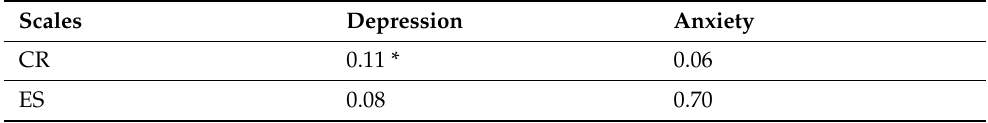
Table 7. Correlations between scales of the Malay version of the ERQ-CA and the DASS-21. Scales Depression Anxiety CR 0.11 * 0.06 ES 0.08 0.70 CR = cognitive reappraisal; ES = expressive suppression. * p < 0.05.